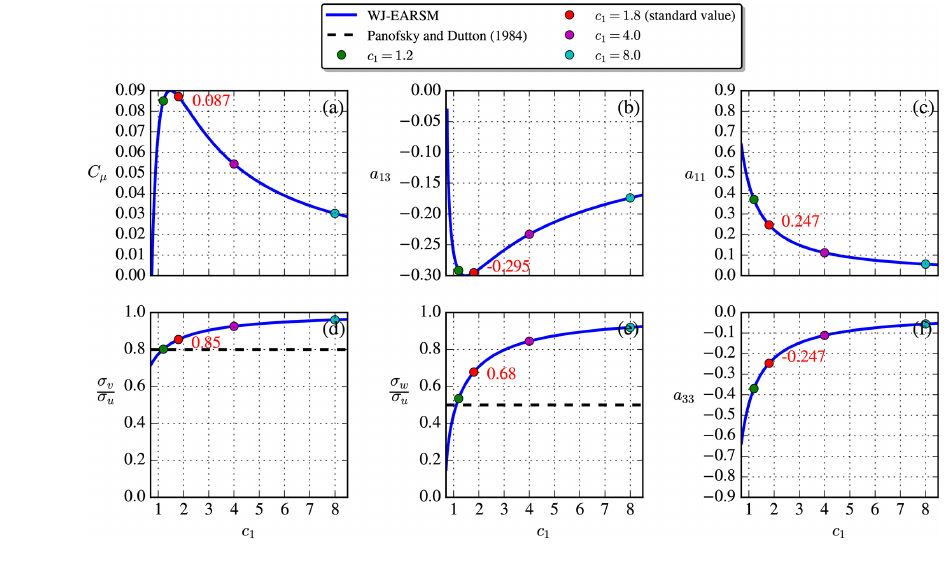
Figure 11. WJ-EARSM dependence on c 1 in the neutral ASL ( P /ε = 1).